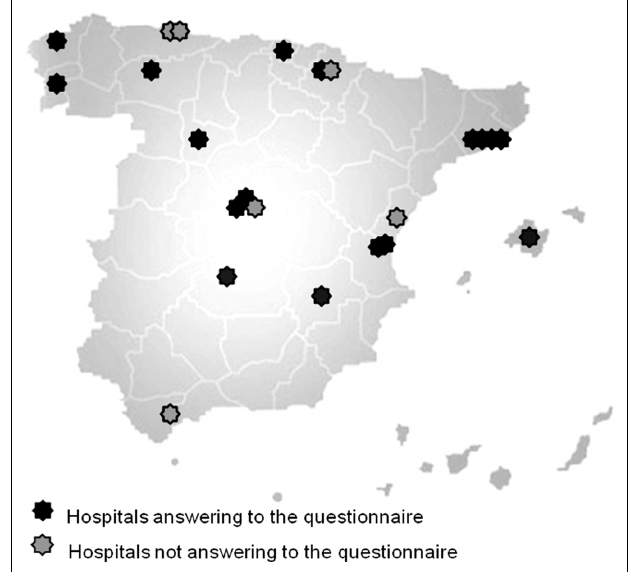
FIGURE 2 | Distribution of participating hospitals according to whether or not they responded to the questionnaire.